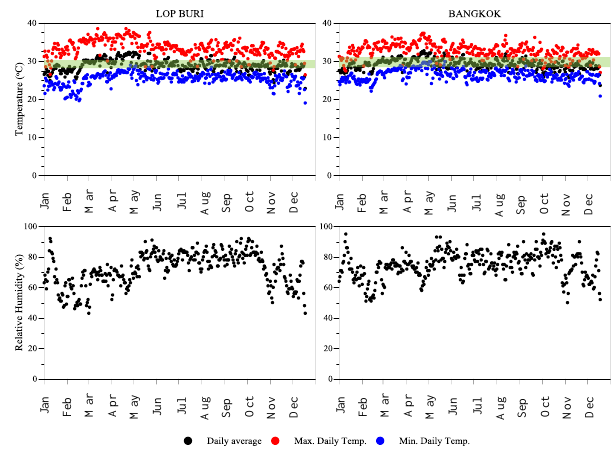
Figure 1. Annual temperature ( upper ) and relative humidity ( bottom ) variations measured in Bangkok and Lopburi Province (2017). Green shading shows the average shallow ground temperature at depths of 0–100 m [36].